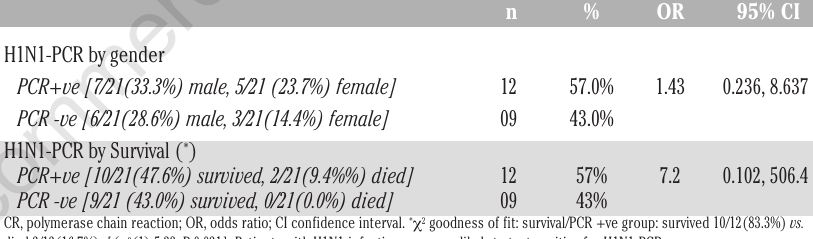
Table 3. Distribution of outbreak patients by H1N1- polymerase chain reaction, by gen- der, by survival (n=21).